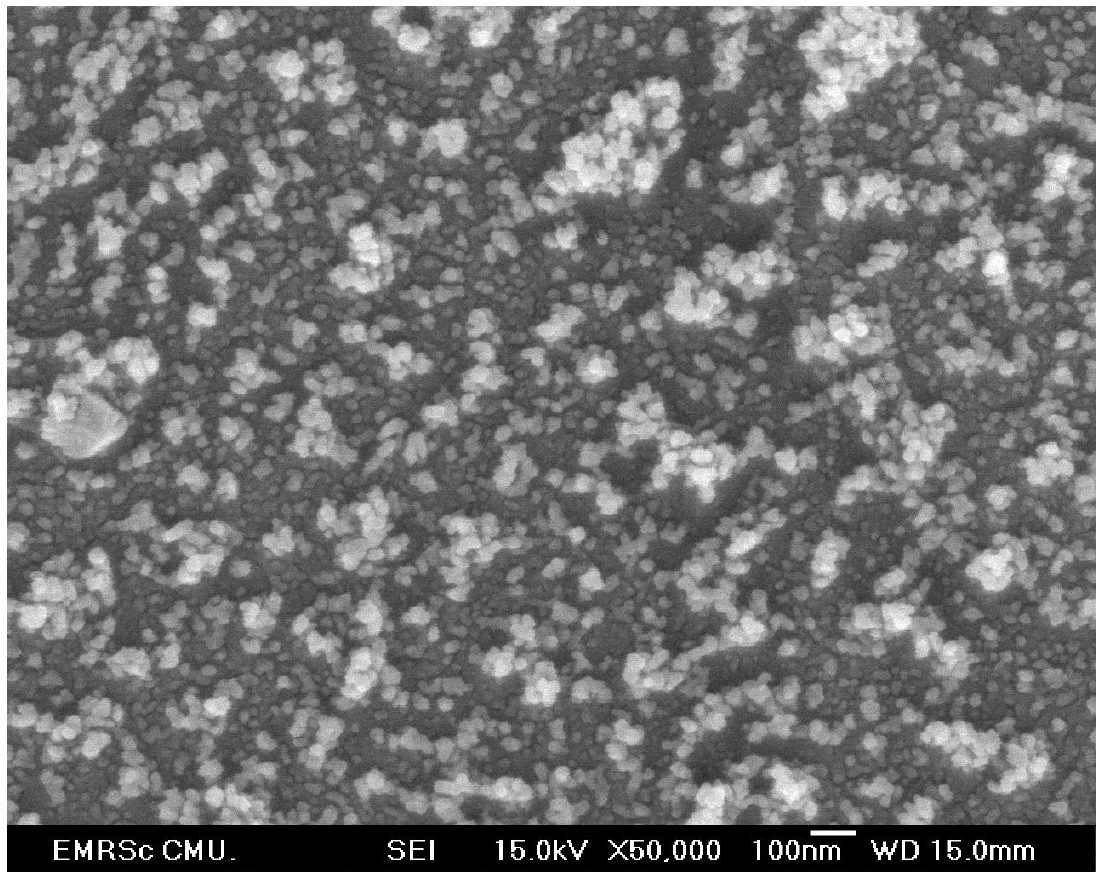
Figure 7. Scanning electron microscopy (SEM) of sparked titanium nanoparticles.